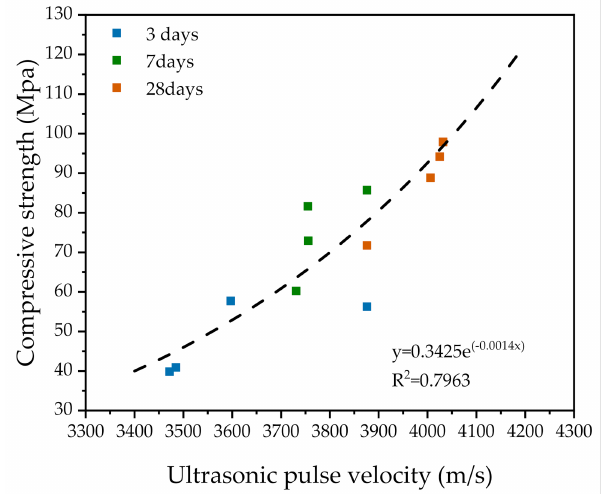
Figure 16. Correlation between UPV and compressive strength corresponding to 3, 7, and 28 days of